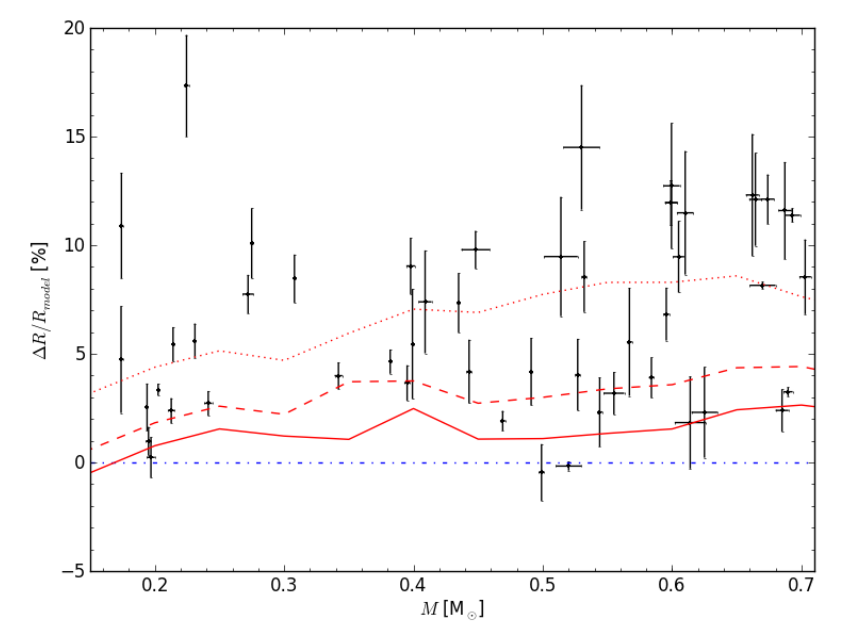
Figure 2. Relative radius difference with respect to the BHAC15 1Ga stellar model as a function of the mass of the star. Red lines correspond to SPOTS models as labeled in Figure 1. The horizontal blue dot-dashed line is shown as a reference of agreement with the BHAC15 1Ga